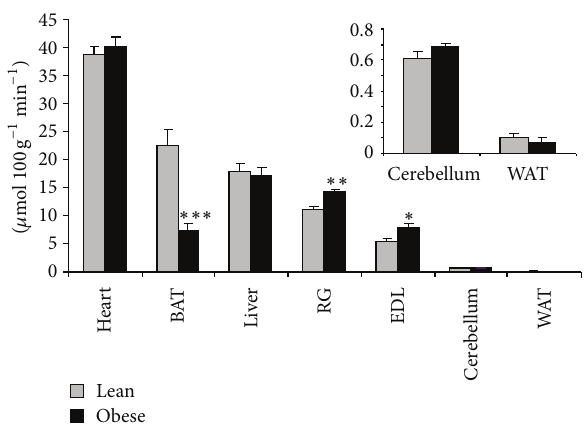
Figure 4: FA oxidation capacity of individual tissues, determined ex vivo , based on the ability of tissue homogenates to oxidize palmitate. Results are expressed as mean ± SE ( 𝑛 = 5 per group). ∗ 𝑃 < 0.05 , ∗∗ 𝑃 < 0.01 , ∗∗∗ 𝑃 < 0.001 versus Lean.